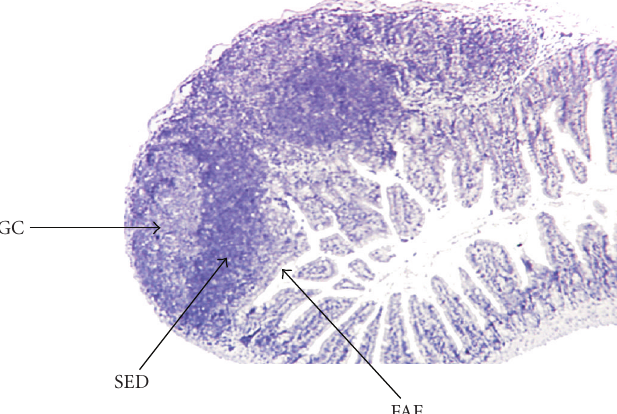
Figure 2: Histological features of a Peyer’s patch. Three follicles are individualized. Arrows show the germinal center (GC); subepithelial dome (SED) and follicle associated epithelium (FAE) for one of these